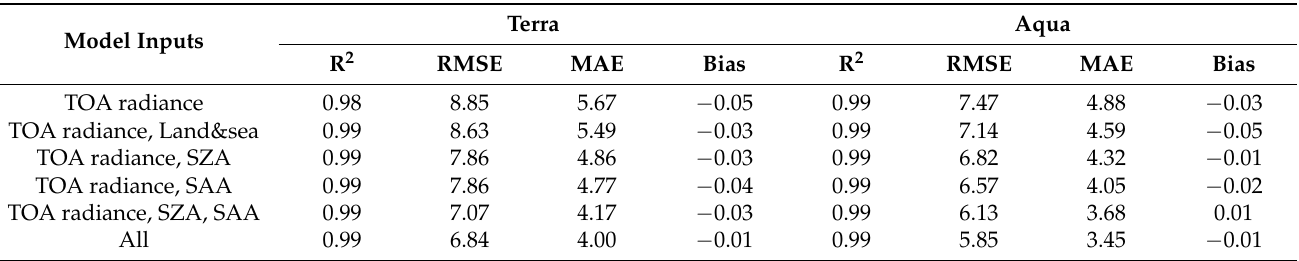
Table 4. Comparison of the ERT model training accuracies with samples from Terra and Aqua on different combination schemes of input variables. The units of RMSE, MAE, and bias metrics are W/m 2